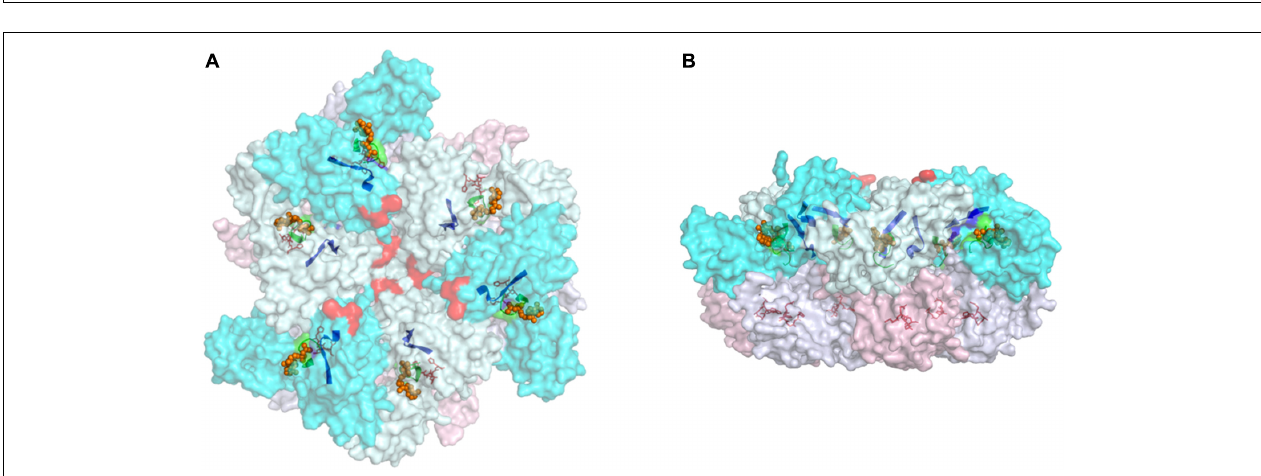
FIGURE 1 | Schematic representation of domains of FtsH2 from Synechocystis sp. PCC 6803. Annotations: transmembrane domain (TM), ATPase domain (AAA + ATPase) and protease domain (Protease) are illustrated as colored boxes. The TM domain includes two transmembrane helices (yellow) and a soluble linker exposed to the thylakoid lumen (blue). The soluble regions exposed to the cytoplasm include a flexible linker (green), ATPase (cyan), and protease domains (red). The amino-acid residues that separate each domain are labeled below the colored boxes. Annotated functional motifs include the proposed substrate entry point (FVG); ATP hydrolysis motifs Walker A and B, and the second region of homology (SRH); and the zinc-binding proteolytic site (HEXXH, X represents any amino acid).